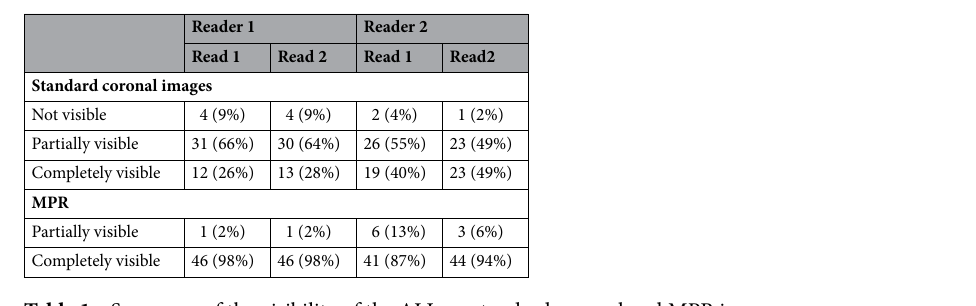
Table 1. Summary of the visibility of the ALL on standard coronal and MPR images.